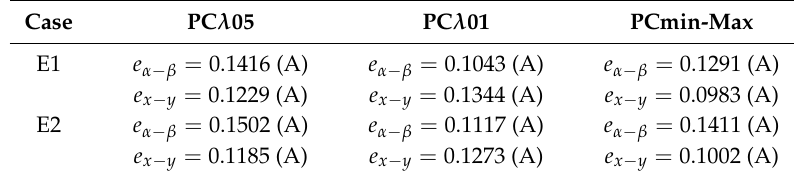
Figure 3. Photographs of the various elements of the experimental setup. Table 3. Experimental results for the traditional and proposed predictive controllers in terms of tracking